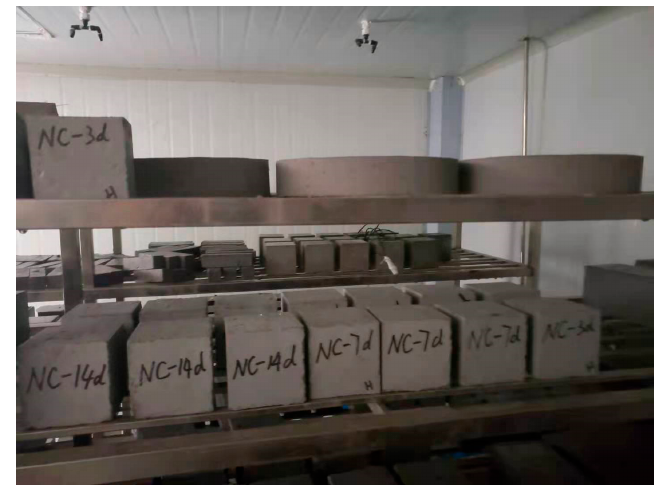
Figure 1. C oncrete curing process. Figure 1. Concrete curing process.